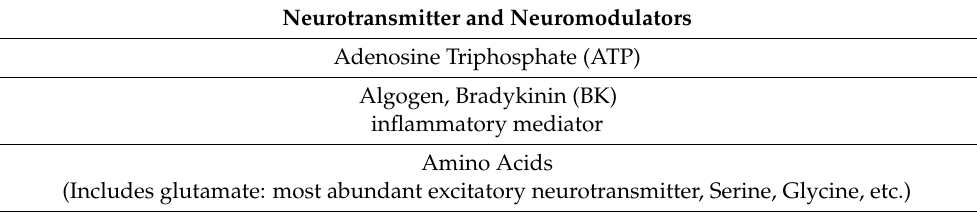
Table 1. Neurotransmitters and neuromodulators of the central, peripheral, and enteric ner- vous systems. Neurotransmitter and